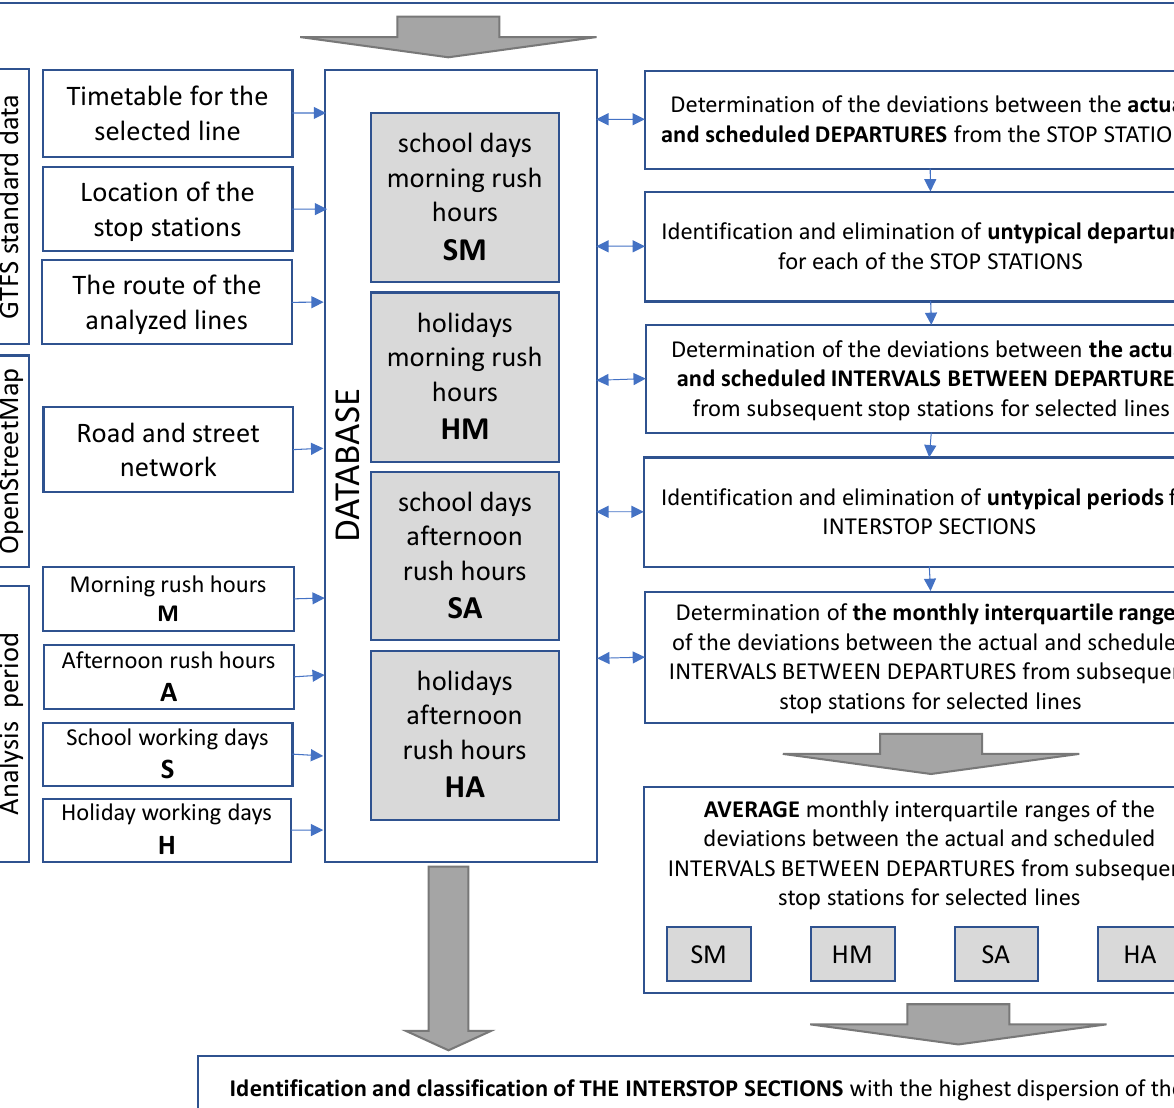
AVERAGE monthly interquartile ranges of the deviations between the actual and scheduled INTERVALS BETWEEN DEPARTURES from subsequent stop stations for selected lines